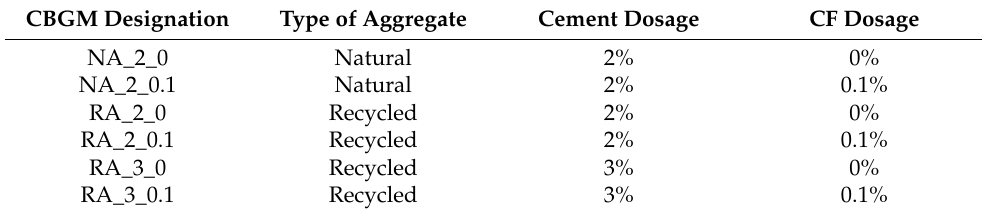
Table 1. Designation and constituents of the six CBGM compositions studied.